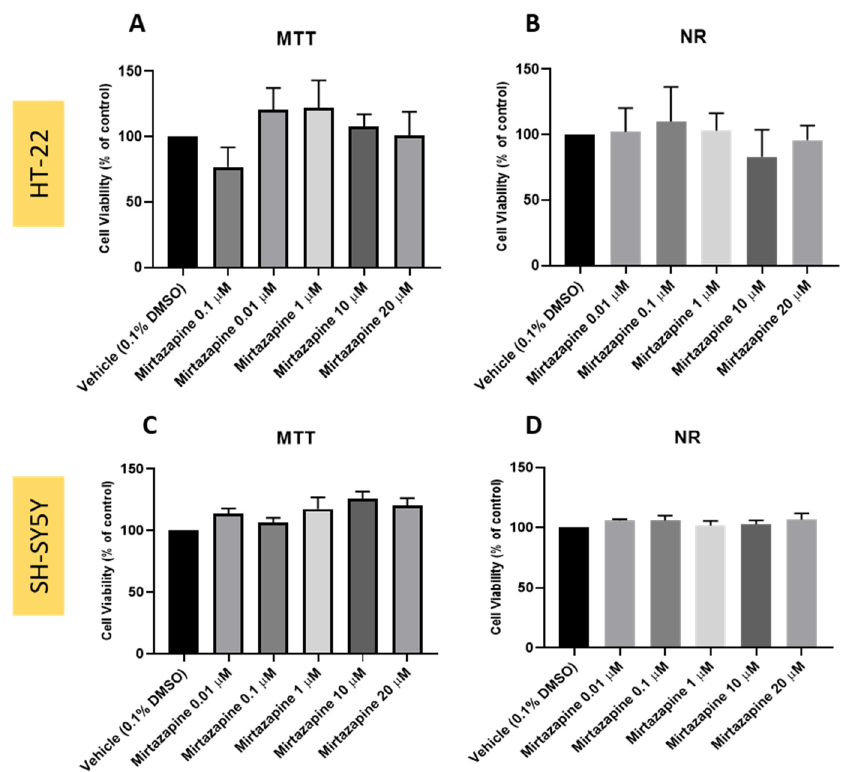
Figure 3. Effect of 48 h-incubation of 0.01–20 µ M of mirtazapine on the viability of HT-22 and SH-SY5Y cells, determined by ( A , C ) MTT and ( B , D ) NR methodology. The results represent the mean ± SEM of three independent experiments, expressed as the percentage of the vehicle (100%).